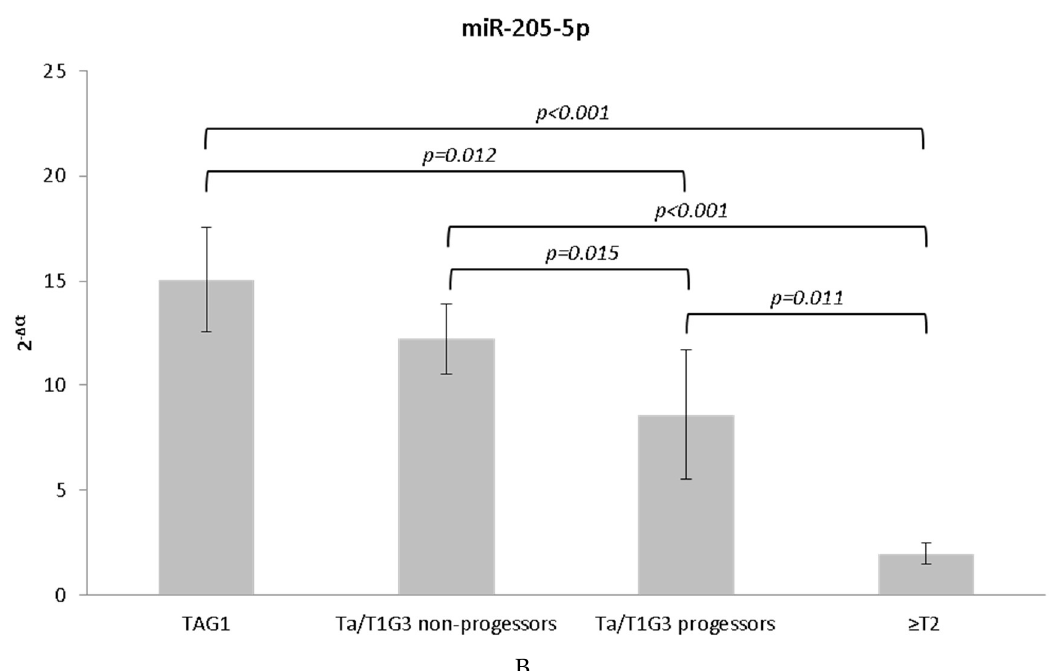
Figure 2. Normalized qRT-PCR expression levels. Expression correlated with the degree of invasiveness of the tumor samples for ( A ) miR-203a-3p and ( B ) miR-205-5p. Error bars represent the standard error of the mean. Significant differences are indicated with brackets; all remaining comparisons were not significant at p < 0.050.